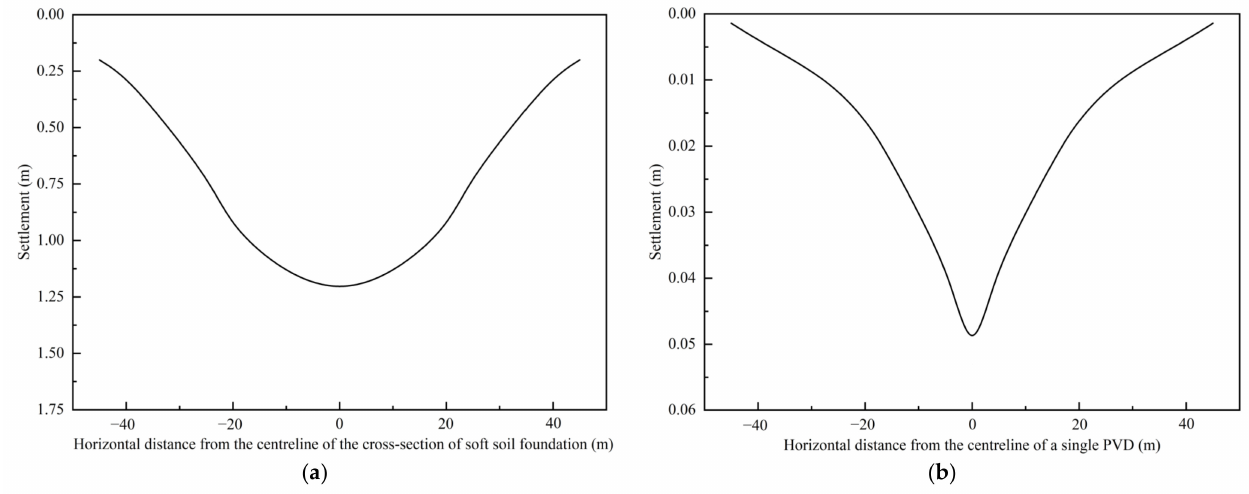
Figure 8. Settlement curve based on the stochastic medium model: ( a ) cross-section settlement curve of a soft soil foundation in the coastal area of South China and ( b ) settlement curve of a single PVD. Layered sand blowing and surcharge loading were implemented during